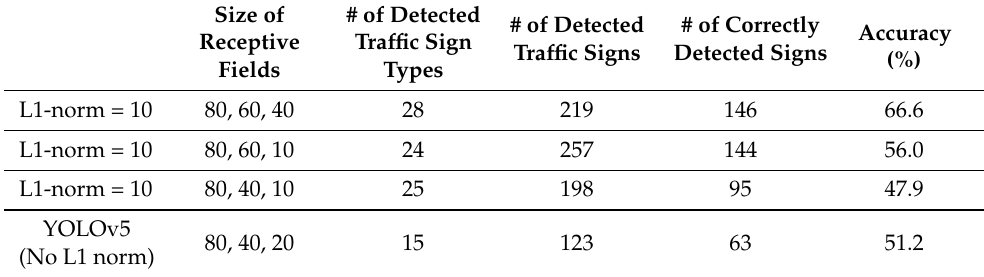
Table 2. Selection of receptive field sizes based on the